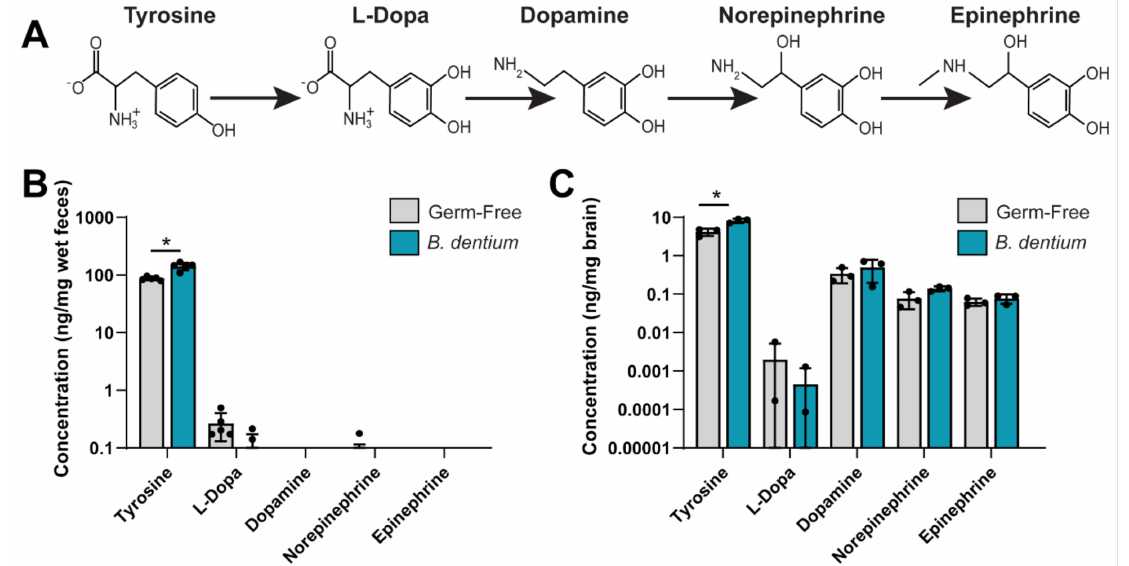
Figure 4. ( A ). Depiction of the tyrosine pathway. ( B ). Analysis of tyrosine, L-dopa, dopamine, norepinephrine, and epinephrine measured from a known mass of stool (ng/mg wet feces weight) by LC-MS/MS reflecting in vivo levels of these neurotransmitters from germ-free and B. dentium mono-associated mice. ( C ). Concentrations of tyrosine, L- dopa, dopamine, norepinephrine, and epinephrine in a known mass of whole brain homogenate (ng/mg brain). For all experiments, n = 5 mice/group; two-way ANOVA, * p <